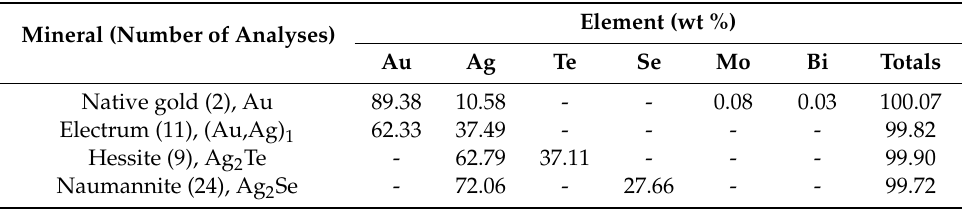
Note: “-“, not detected.